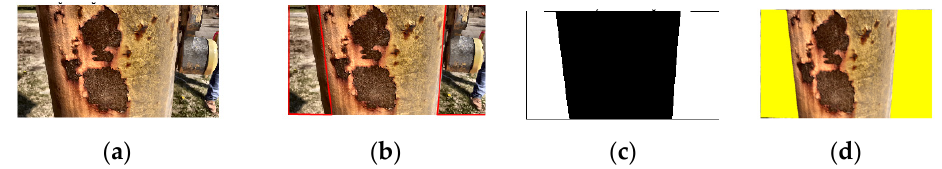
Figure 7. ( a ) Original image; ( b ) selected regions as background; ( c ) binary mask of background; ( d ) overlaid image.